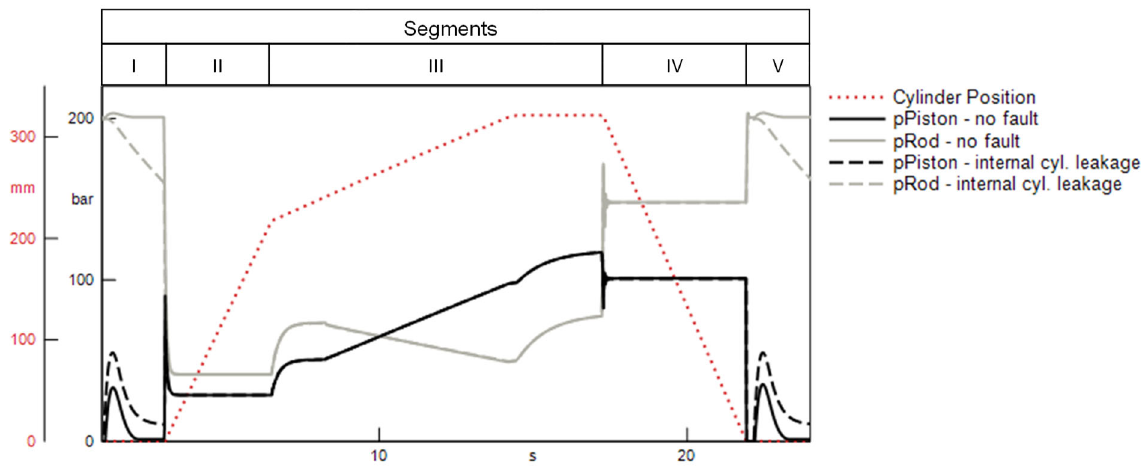
Figure 11. Simulated effect of an internal cylinder leakage on the cylinder pressures.